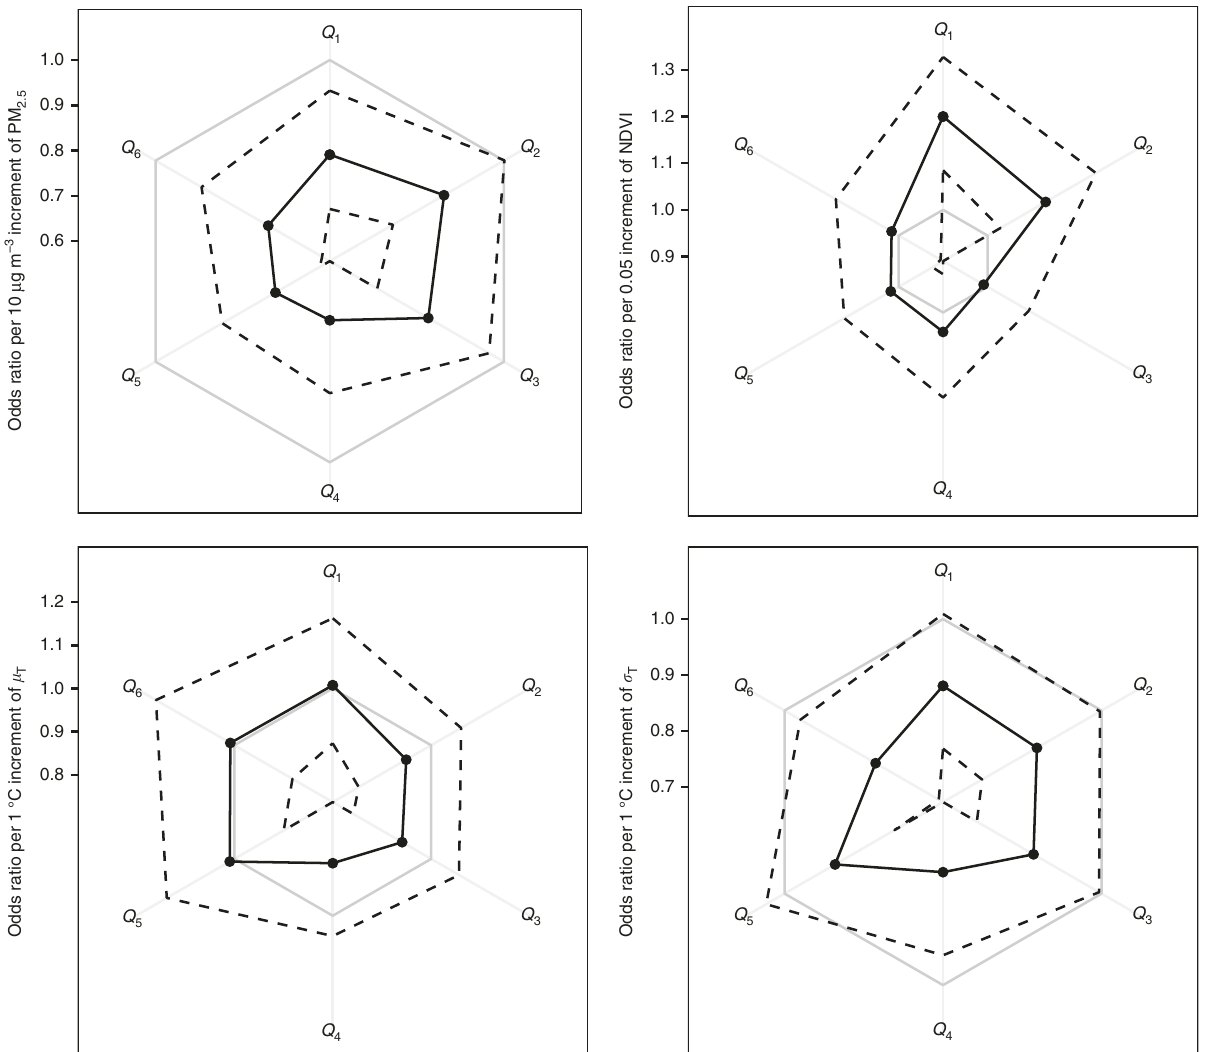
Fig. 2 Environmental effects on different dimensions of mental health. The effects are evaluated by fully adjusted associations between the question- speci fi c mental health scores and the four environmental factors. Black dots and black solid polygons: estimated odds ratios (ORs); black dashed polygons: corresponding 95% con fi dence intervals; gray polygons: references of no effect (OR = 1); gray radial lines: different dimensions of mental health; Q 1 : feeling depressed and incapability to cheer up no matter what you are doing; Q 2 : feeling nervous; Q 3 : feeling upset; Q 4 : feeling hopeless about the future; Q 5 : feeling that everything is dif fi cult; Q 6 : thinking life is meaningless. Along a gray radial line, its interaction with a polygon presents the